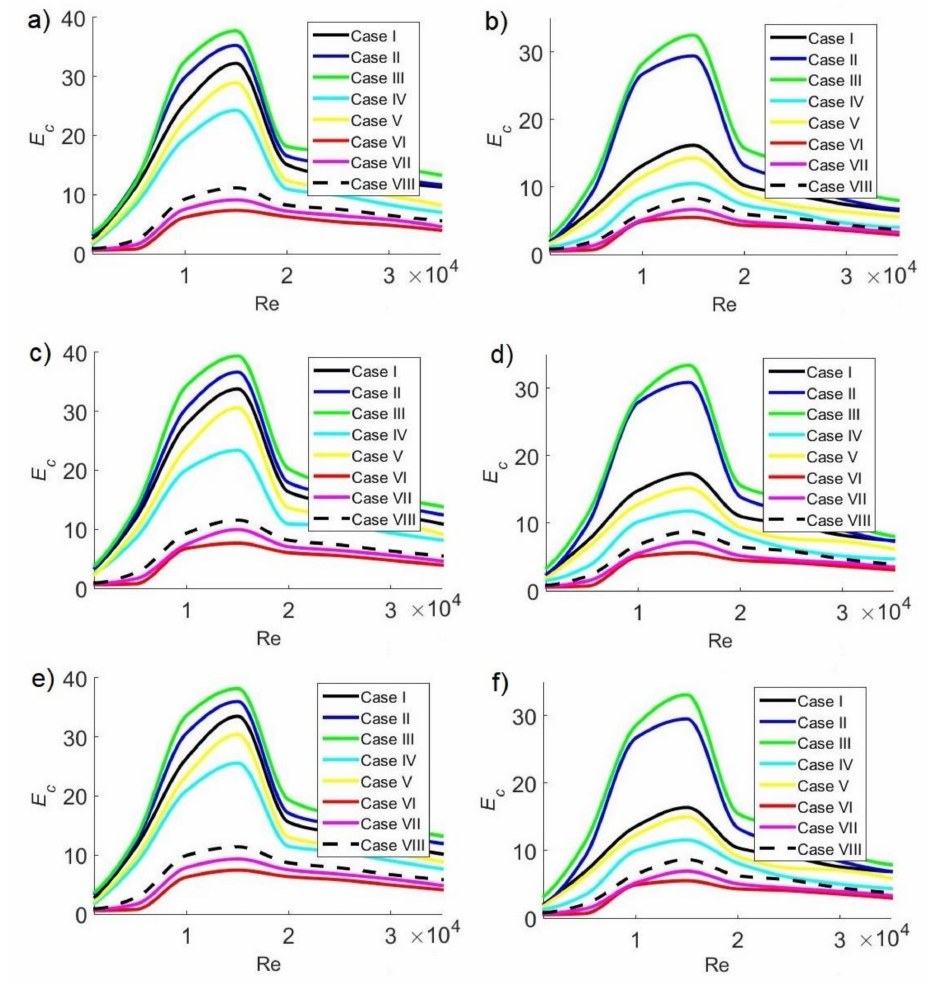
Figure 13. Overall ventilation effectiveness for CO 2 removal in the classroom as a function of Reynolds number at 11:30 a.m. with CO 2 sources of ( a ) 35,000 ppm and ( b ) 42,500 ppm; at 3:30 p.m. with CO 2 sources of ( c ) 35,000 ppm and ( d ) 42,500 ppm; and at 6:30 p.m. with CO 2 sources of ( e ) 35,000 ppm and ( f ) 42,500